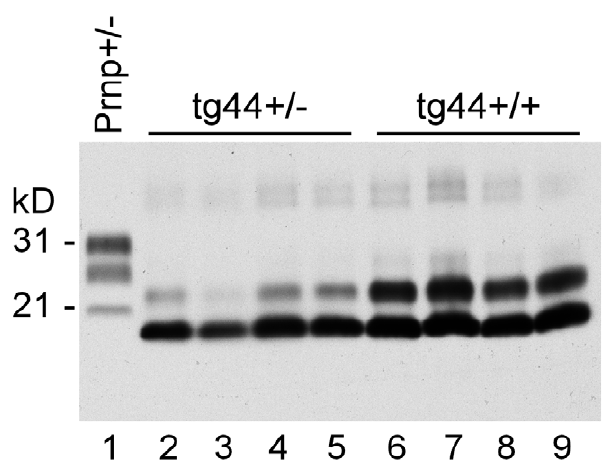
Figure 3. Detection of PrPres by immunoblot using monoclonal antibody D13. Comparison of PrPres in brain of 22L scrapie-infected tg44 + / + and tg44 + / 2 mice at the time of clinical disease. All lanes were loaded with 0.25 mg brain tissue equivalents. A clinical Prnp + / 2 mouse is shown for comparison. Lane 1: Prnp + / 2 (251 dpi), PrPres bands are seen at 21, 28, and 31 kD; lanes 2–5: tg44 + / 2 mice (567, 589, 594,